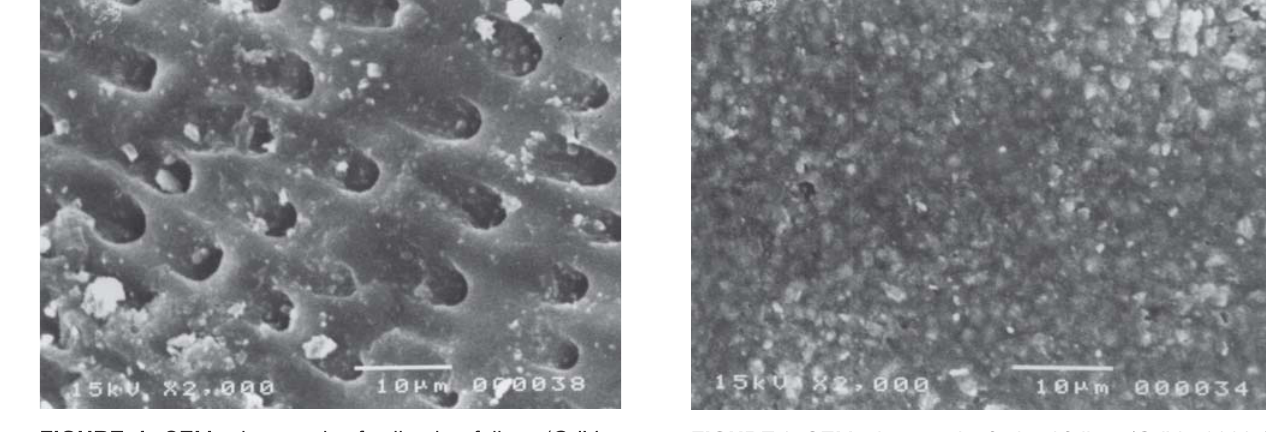
FIGURE 6- SEM micrograph of mixed failure (G-IV –